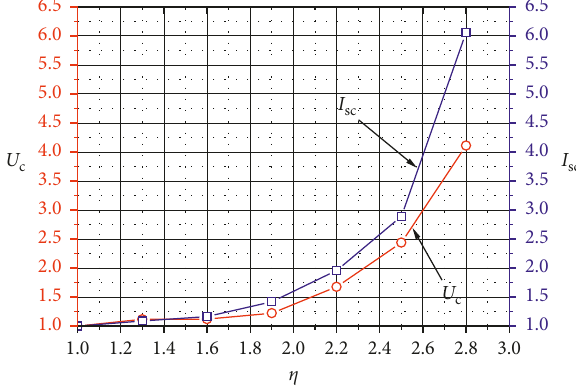
Figure 11: The relation curves for η - U